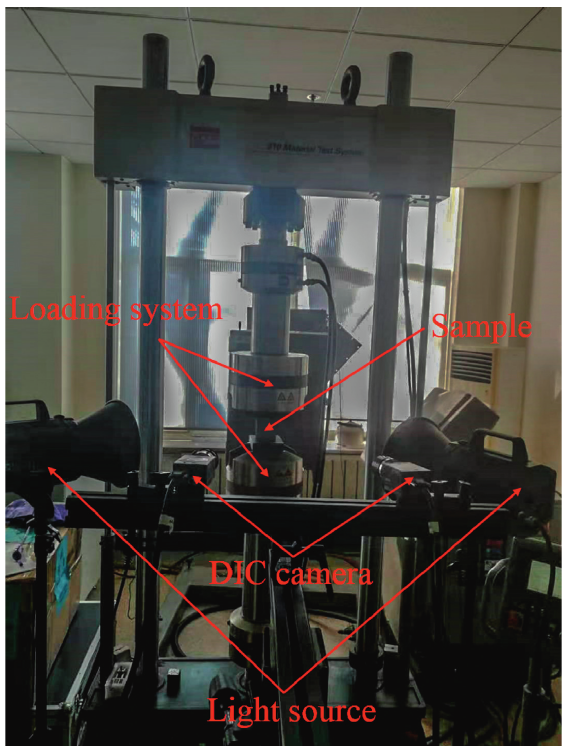
Figure 3: MTS-810 and DIC